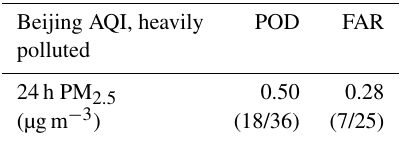
Table 4. POD and FAR for PM 2 . 5 for Beijing under heavily polluted